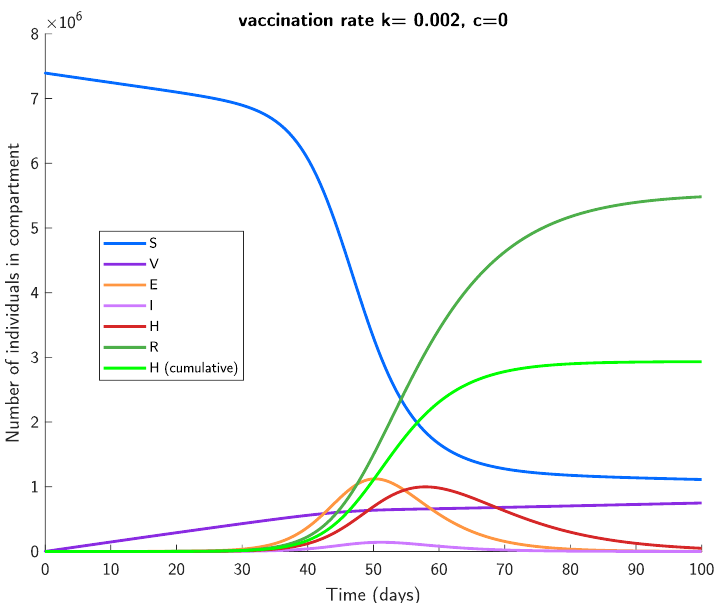
Figure 2. Evolution of the SVEIHR model for the ancestral strain of SARS-CoV-2, with parameters ( ε , α , β , γ , δ ) = ( 0.48,0.5,0.14,1,0.1 ) , vaccination rate k = 0.002, vaccine efficacy v e = 0.95, and initial values X ( 0 ) = ( N − 1,1,0,0,0,0 ) . The first six lines in the legend depict the number of individuals in each compartment over time, while the final (bright green) line depicts the cumulative number of hospitalized or isolated individuals.